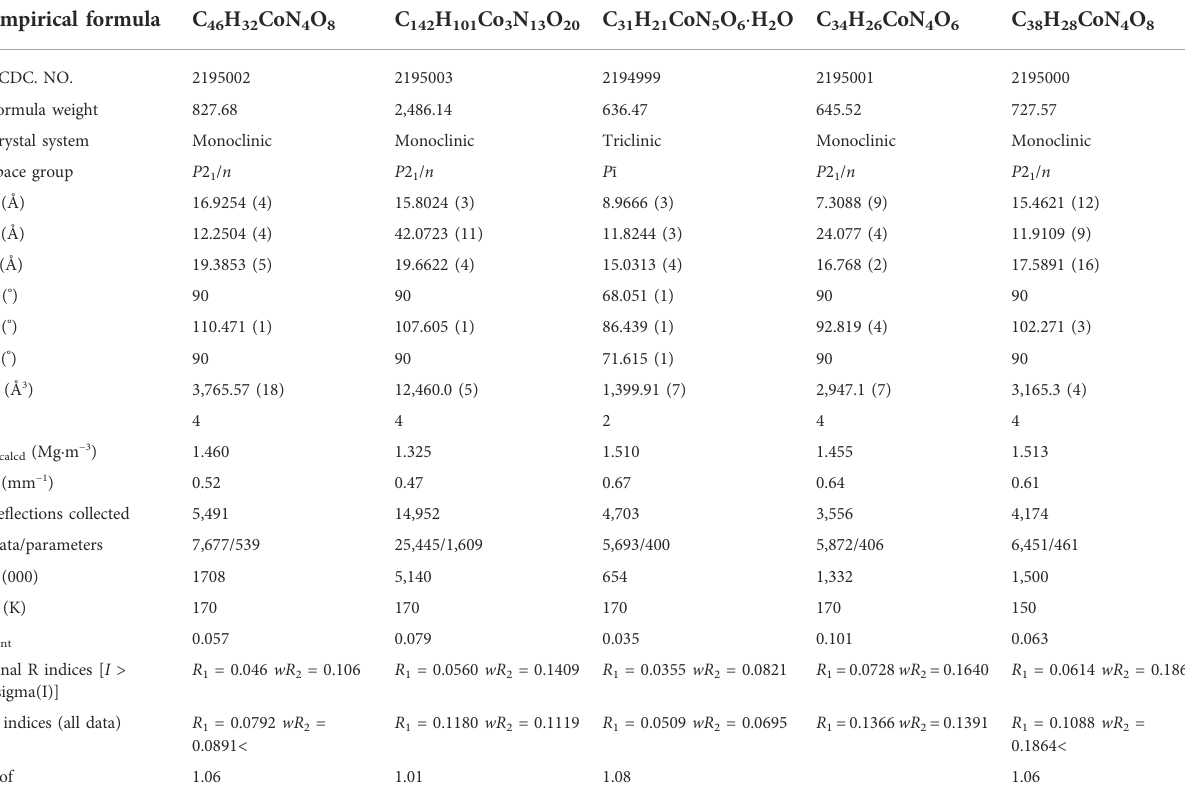
TABLE 1 Summary of crystal data and structure re fi nement parameters for YMUN 1 – 5 a . Empirical